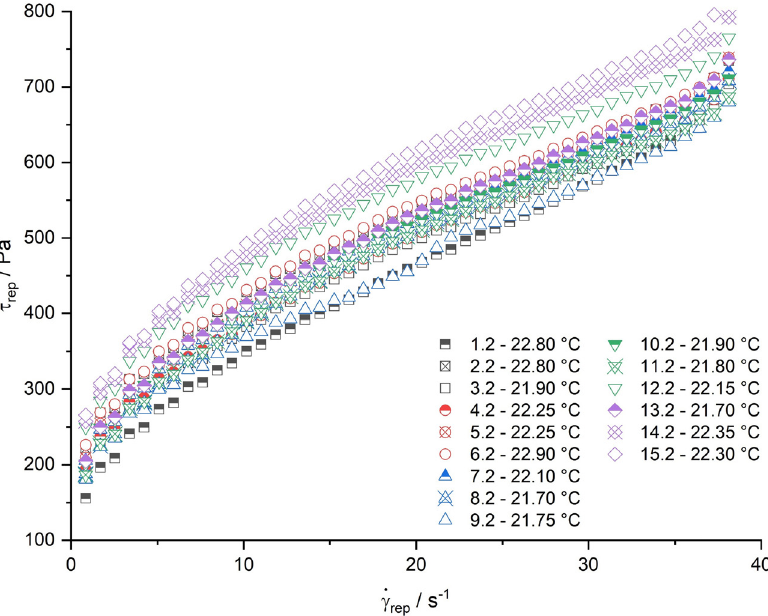
Figure 11: Representative values of the adjusted concrete mix for the second individual measurements of the 15 measurement